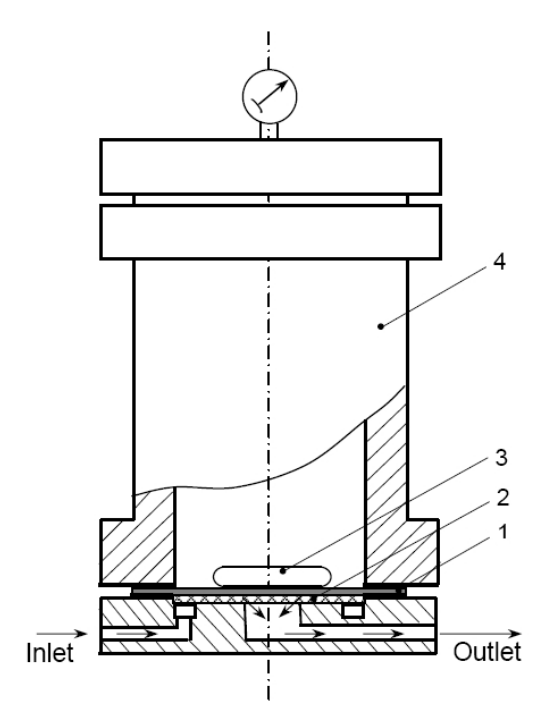
Fig. 5 Installation with countercurrent hydraulic flow through the membrane under pres- sure. 1-membrane, 2-stainless steel screen, 3-magnetic stirrer, 4-pressure vessel. Mem- brane area -10 cm 2